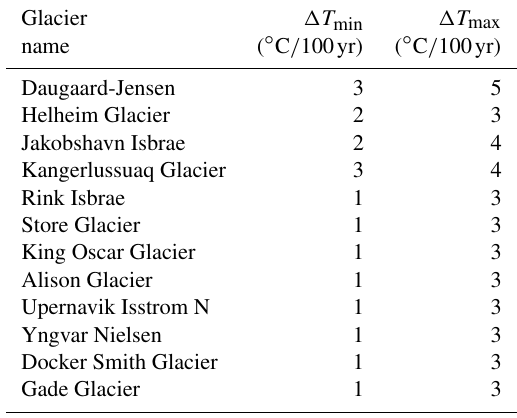
Table 1. Minimal and maximal ocean temperature trend (rounded to the nearest degree Celsius) over 100 years for three CMIP5 models derived from the grid cells closest to each glacier fjord with mini- mum 400m depth. Detailed information are listed in Table S1, Sup-